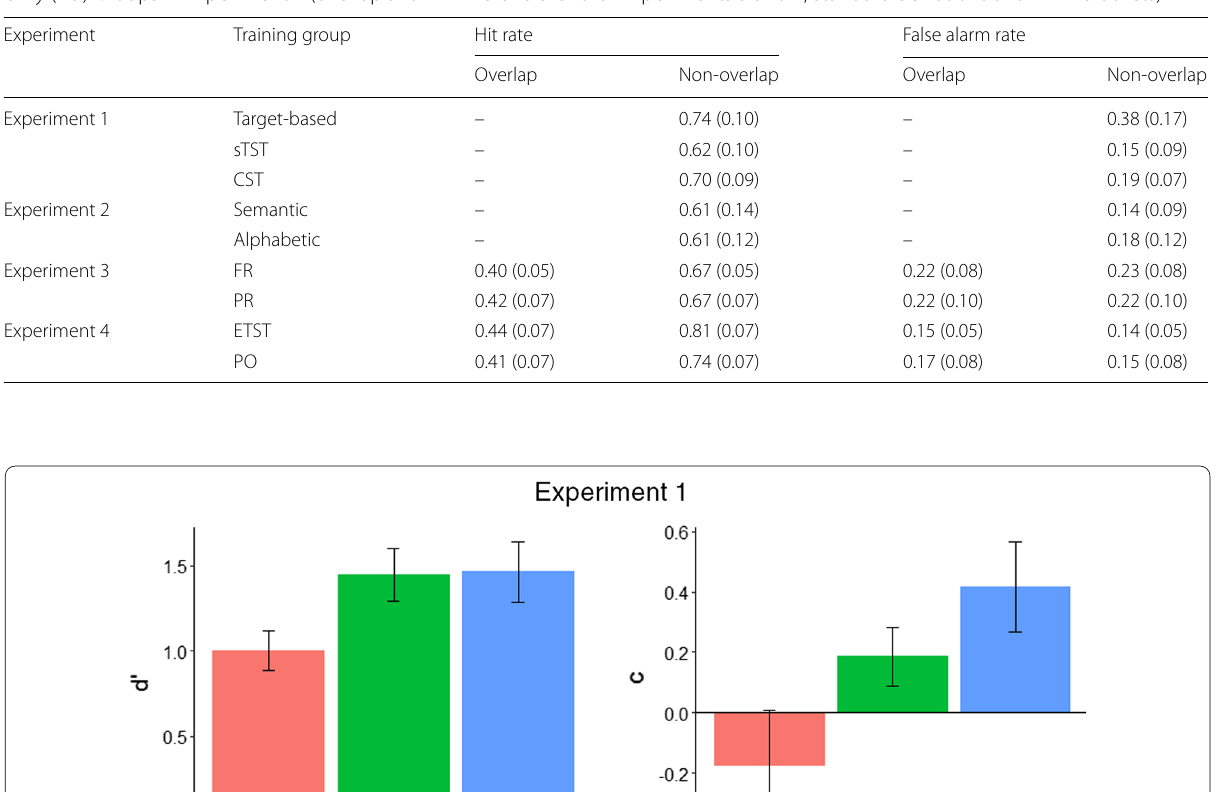
Table 1 Mean Hit Rates and False Alarm Rates for the Target‑based Search Training, Standard Targetless Search Training (sTST) and Combined Search Training (CST) Groups in Experiment 1, Semantic and Alphabetic Training Groups in Experiment 2, Fixed Reward (FR) and Performance‑contingent Reward (PR) Groups in Experiment 3 and the Enhanced Targetless Search Training (ETST) and Practice Only (PO) Groups in Experiment 4 (overlap shown where relevant for Experiments 3 and 4; standard deviations shown in brackets)